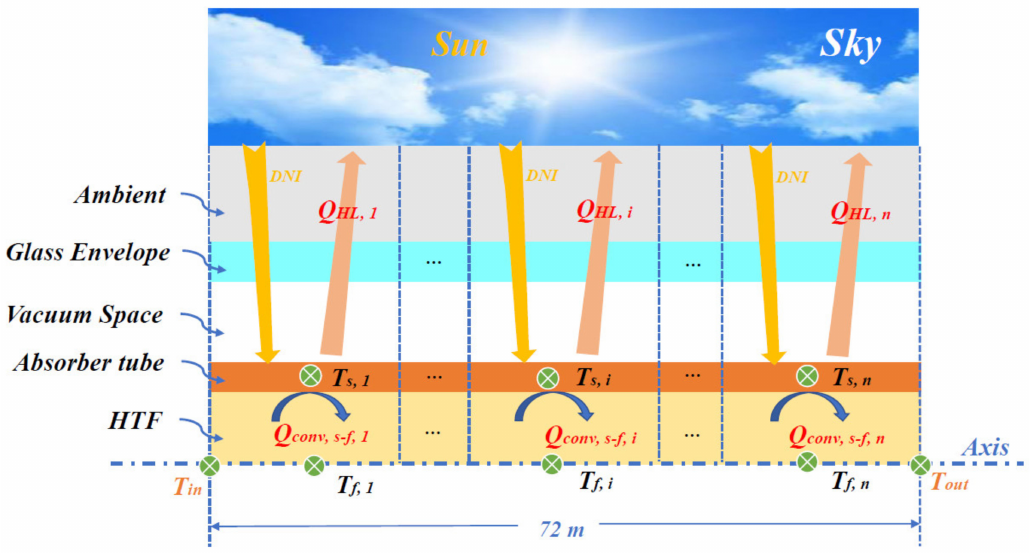
Figure 4. Heat collecting process in the PTC